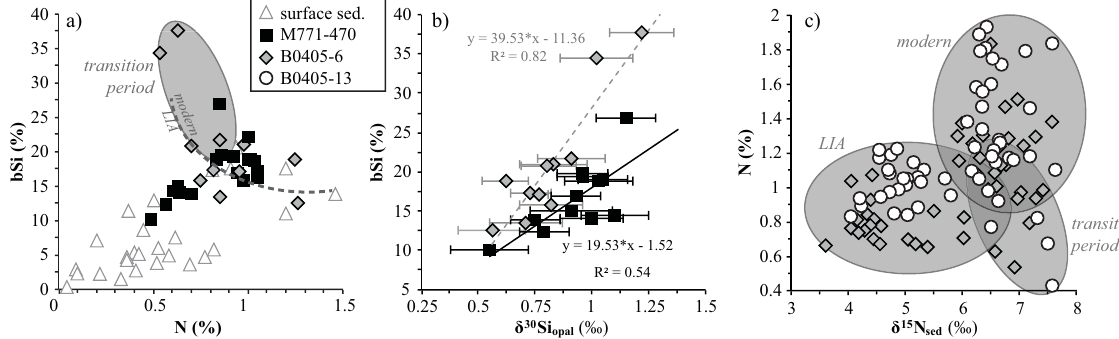
Figure 3. Surface sediment (white triangles) and downcore data (core M771-470: black squares; B0405-6: grey diamonds; B0405-13: white circles) for (a) total N versus bSi concentrations (the dashed line marks the end of the LIA), (b) δ 30 Si opal versus bSi concentration and (c) δ 15 N sed versus total N concentrations. Error bars represent 2 σ (sd) external